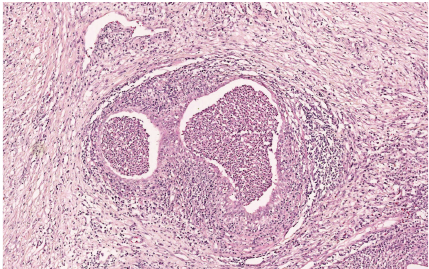
Figure 3: Microabscess in vestigial